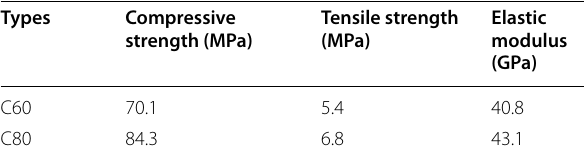
Table 3 Basic mechanical property parameters of high-strength